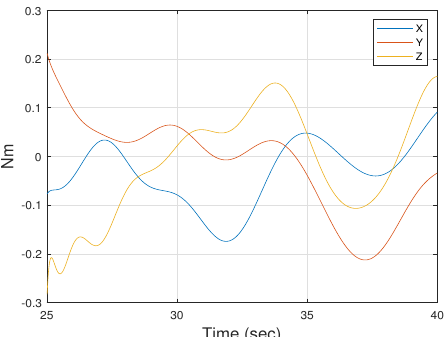
Figure 4. Scenario of external disturbances applied to the UAV.